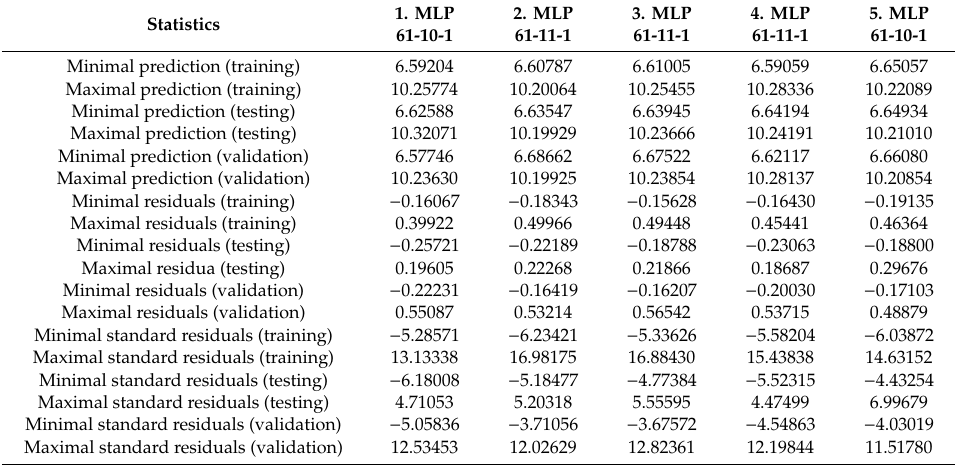
Table 8. Statistics of individual data sets by retained neural structures.